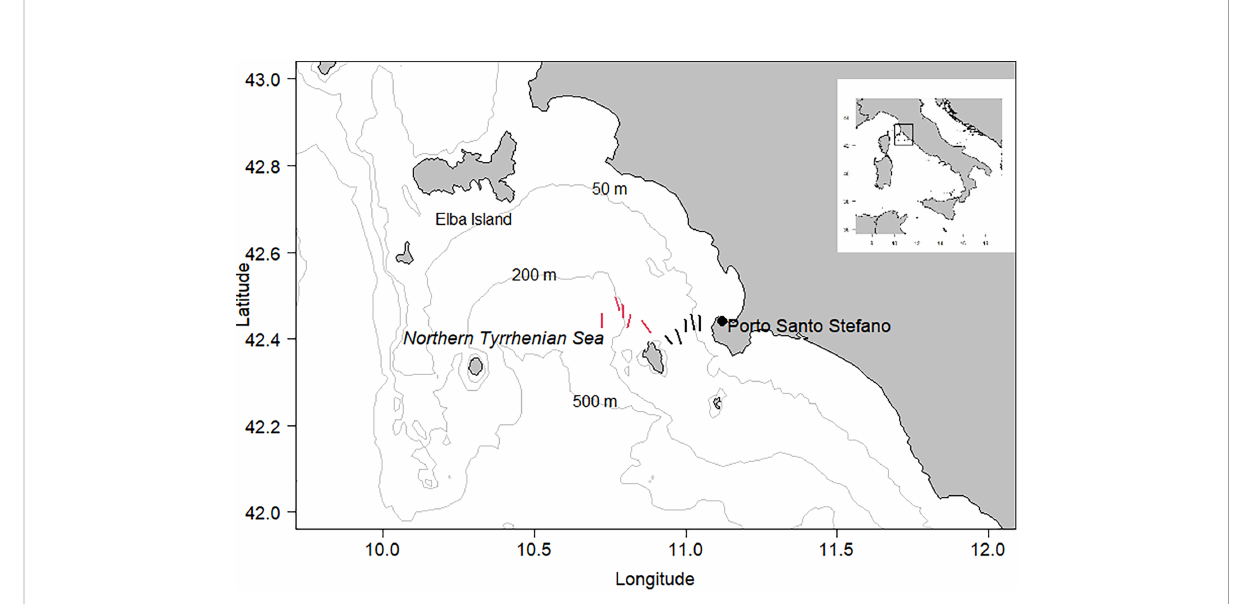
FIGURE 1 Northern Tyrrhenian Sea (part of the FAO-GFCM GSA9). Location of the two transects (red and black lines) selected for the implementation of the